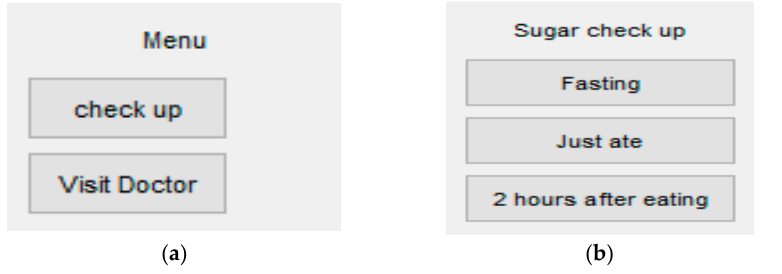
Figure 11. Result: ( a ) Menu Button ( b ) Sugar Check Up.